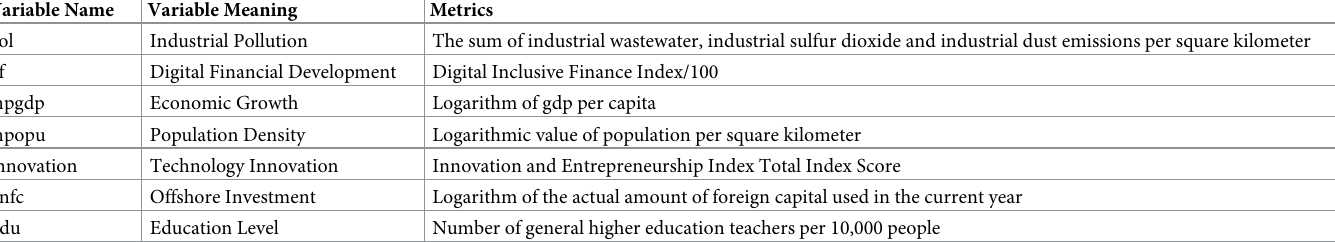
Table 1. Variable selection and